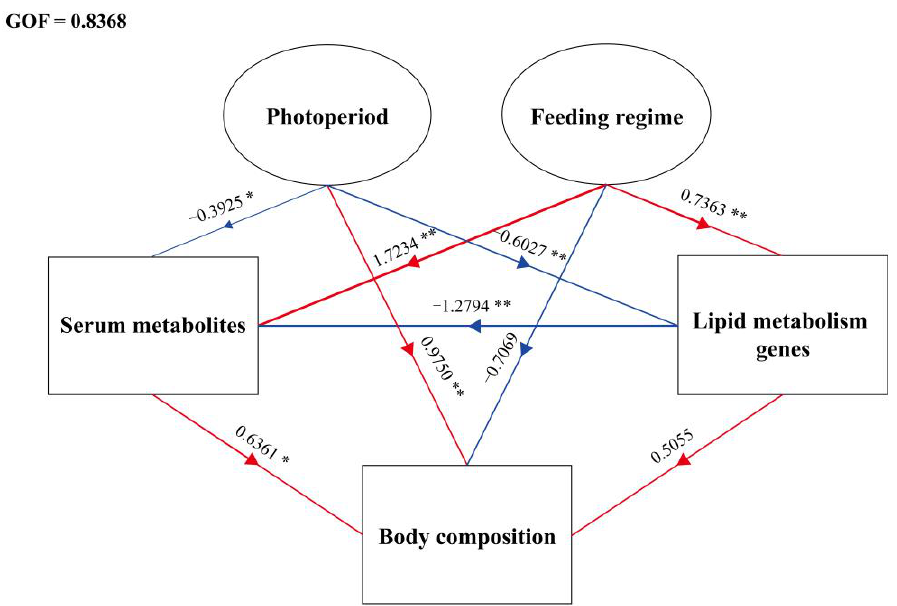
Figure 5. The structural equation model (SEM) based on partial least squares path modeling (PLS-PM) demonstrates the relationships between the photoperiod, feeding regime, digestive enzyme, lipid metabolism genes, serum hormones, serum metabolites, and body composition. Numbers on arrows are path coefficients. * means p < 0.05, ** means p < 0.01. Arrow widths show the strength of the causal relationship. Red arrows indicate positive correlation, blue arrows indicate negative cor- relation.